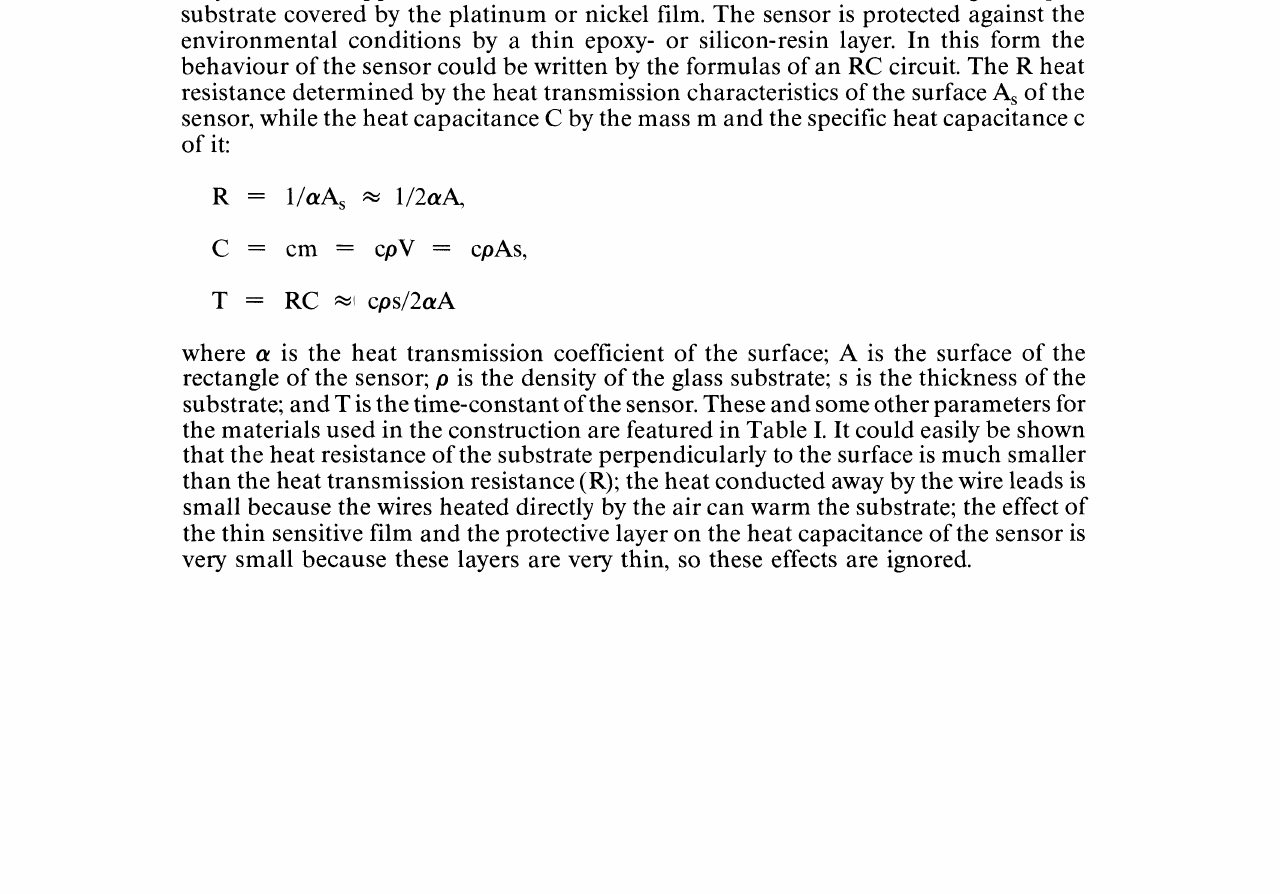
ct= 10... 15mm b= 8mm A=ctb